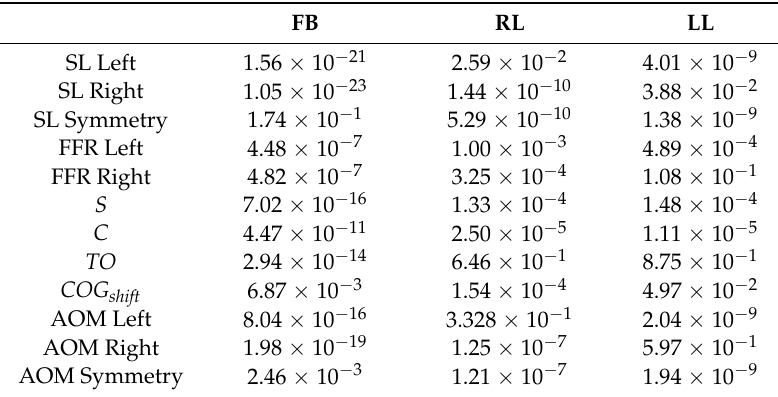
Table 1. Two sample t -test with unequal variances and significance level of 0.05 performed between normal and impaired gait.